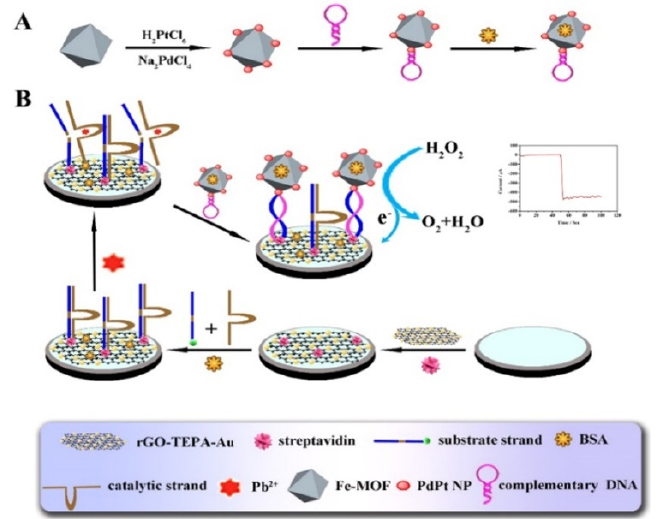
Figure 11. Schematic diagram of: ( A ) the preparation process of Fe − MOFs/PdPt NPs − HP, and ( B ) schematic representation of the proposed strategy for the biosensor. Reprinted with permission from Ref. [231]. Copyright 2018, Elsevier.